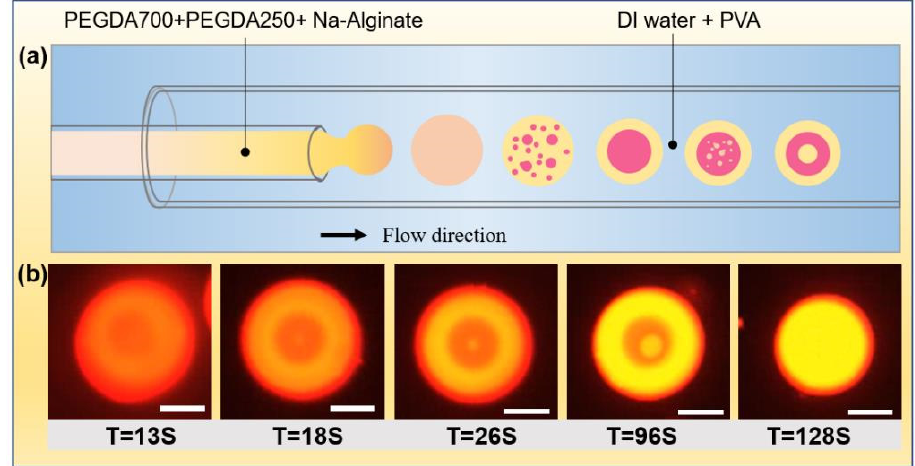
Figure 3. ( a ) Schematics of the microfluidic device used for preparing initial single emulsion droplet and the droplet changed from one layer to two and three layers. ( b ) Formation of single, double, and triple emulsion droplets over time due to phase separation. The scale bar is 100 µm. The hydrophobic fluorescent indicator Nile red was premixed into the inner phase mixture and automatically assembled into the PEGDA 250-rich layer during the phase separation process. The PEGDA 250-rich layer was labeled with a bright yellow fluorescent region.